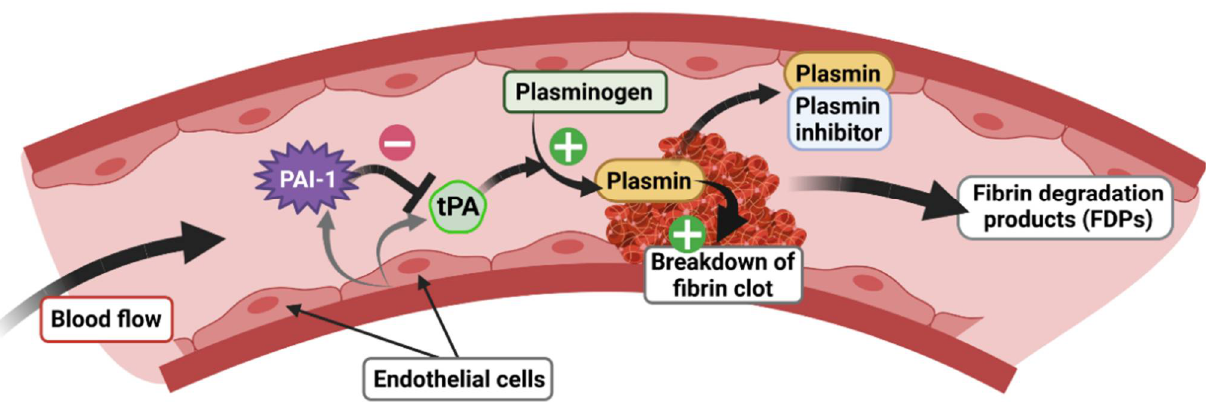
Figure 5. Role of the tPA/PAI-1 system in the regulation of fibrinolysis.